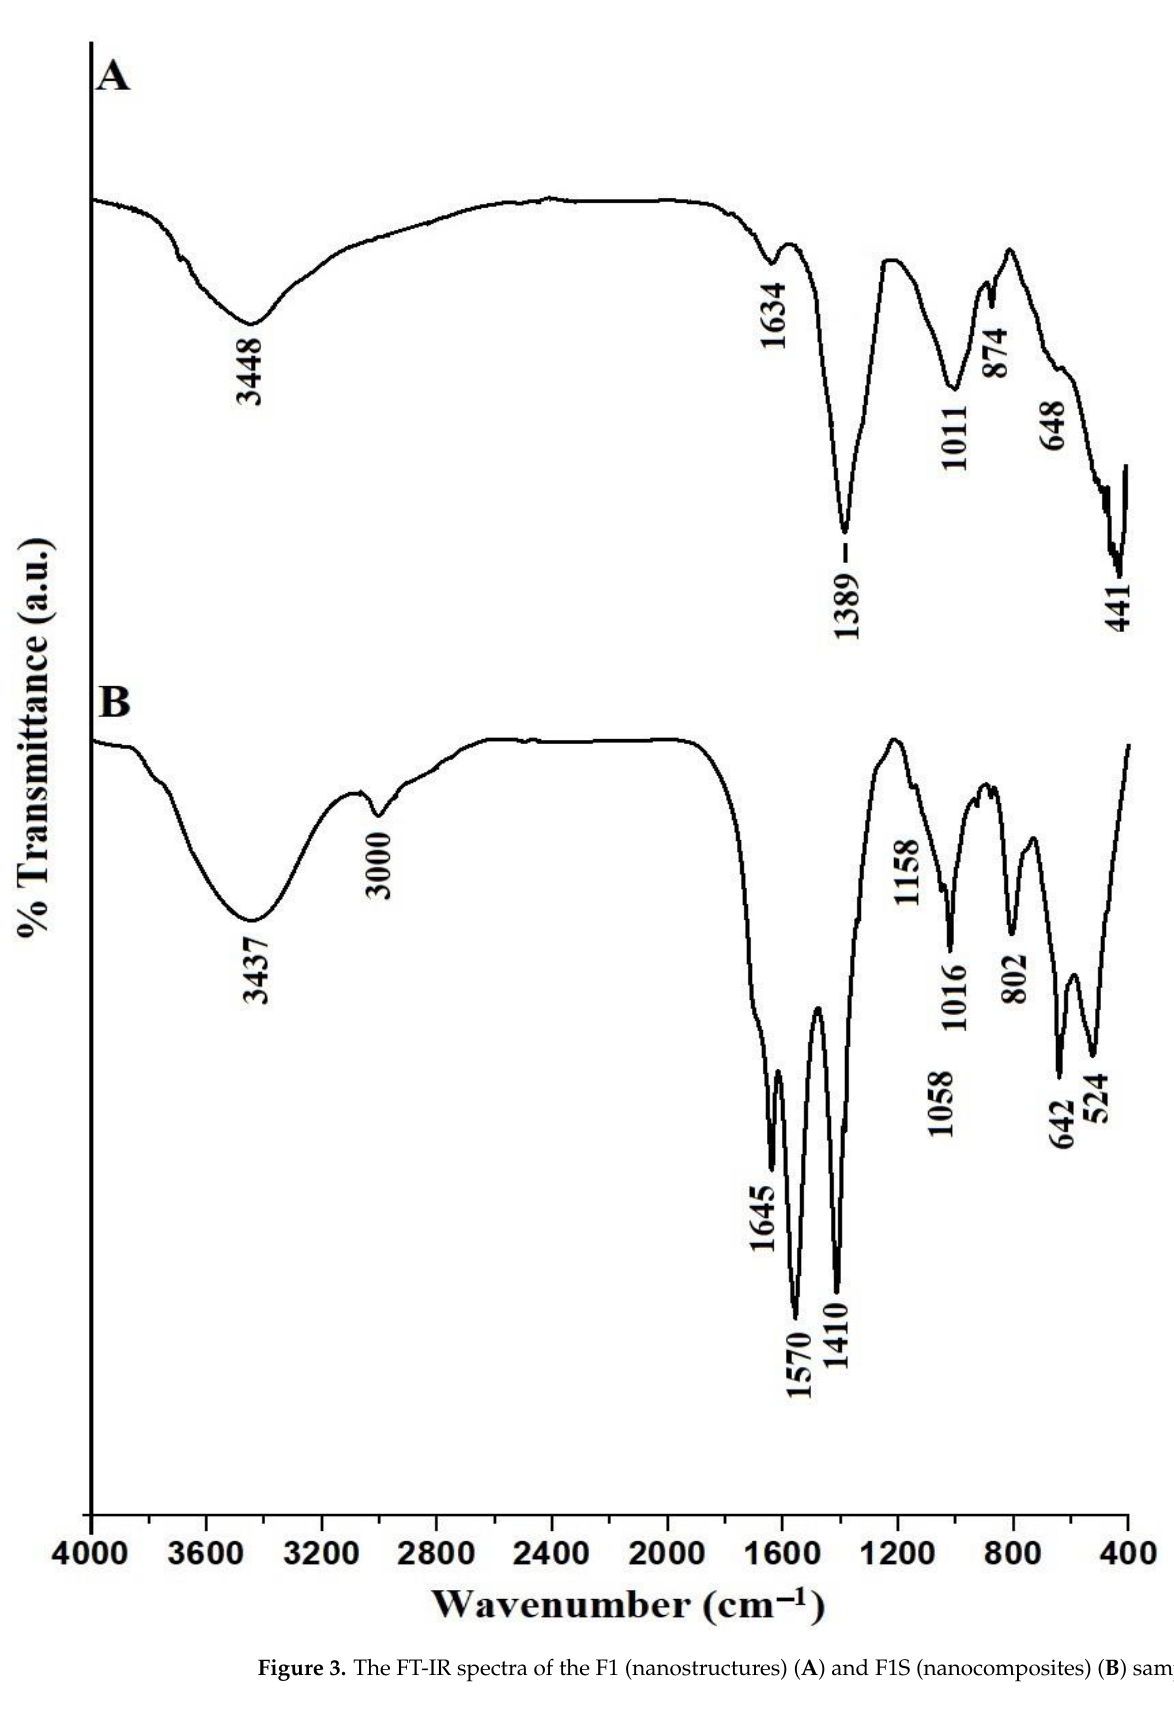
Figure 3. The FT-IR spectra of the F1 (nanostructures) ( A ) and F1S (nanocomposites) ( B ) samples.